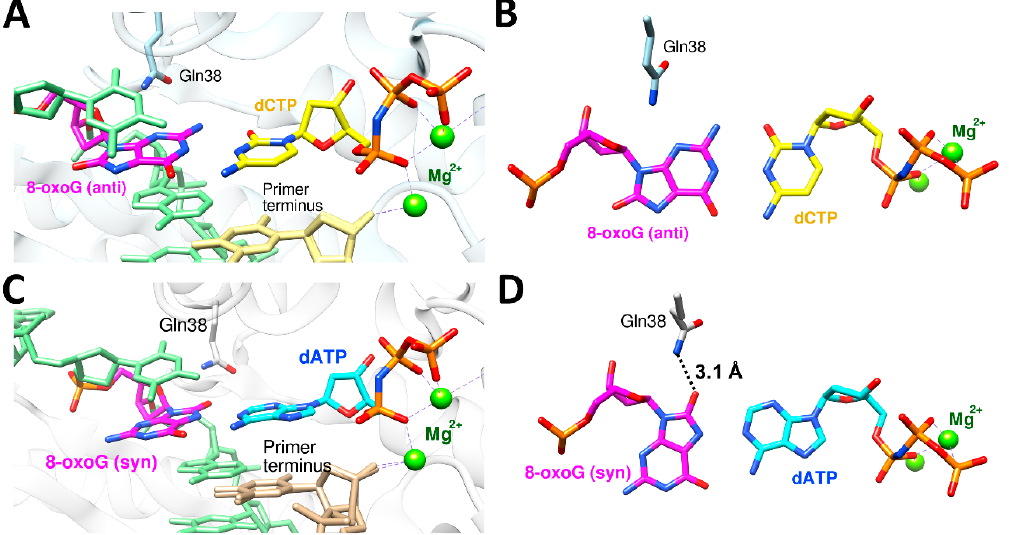
Figure 4. The active site structures of pol η complexed with 8-oxoG and the incoming nucleotides, dCTP (PDB ID: 4O3P) and dATP (PDB ID: 4O3O). ( A ) 8-oxoG (anti) and the incoming dCTP* in the active site of pol η with catalytic Mg 2+ , primer, template, and Gln38 shown. ( B ) The canonical base pair between 8-oxoG (anti) and dCTP* with no additional interaction with Gln38. ( C ) 8-oxoG (syn) and the incoming dATP* in the active site of pol η with catalytic Mg 2+ , primer, template, and Gln38 shown. The primer terminus shows two alternative conformations. ( D ) Non-canonical base pair between 8-oxoG (syn) and dATP*, and this base pair is further stabilized by the hydrogen bonding interaction with Gln38.